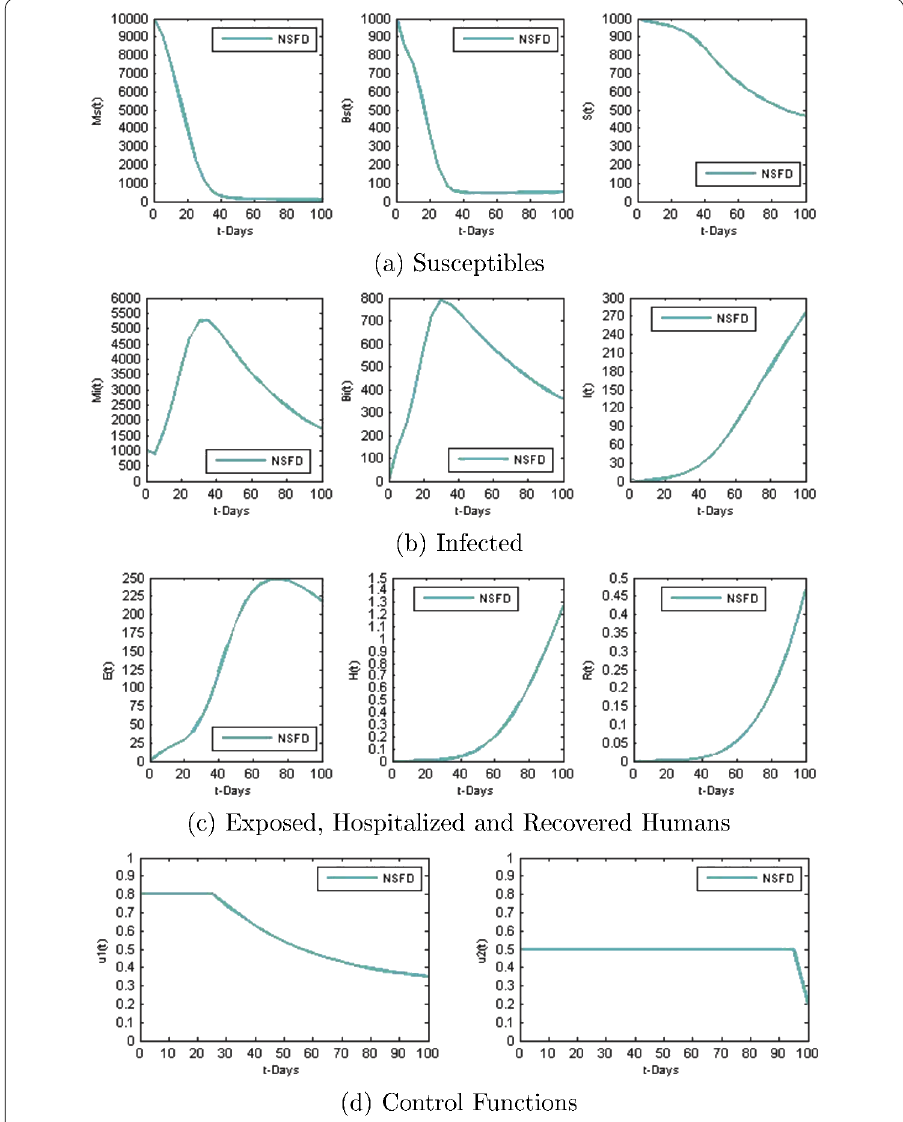
Figure 3 The approximate solutions of the fractional delay optimal control problem by using NSFDM. When 0 ≤ u 1 ≤ 0.8, 0 ≤ u 2 ≤ 0.5, with d = 10 and α = 1, and (cid:7) t =